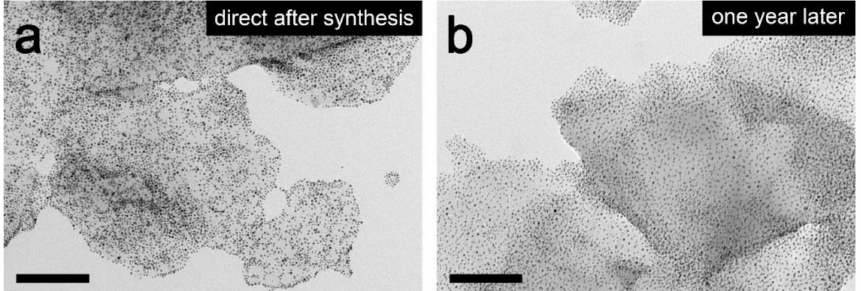
Figure 9. Micrographs of the same sample of CRGO@AuNP hybrid material directly after synthesis ( a ) and a year after ( b ). Scale bars represents 200